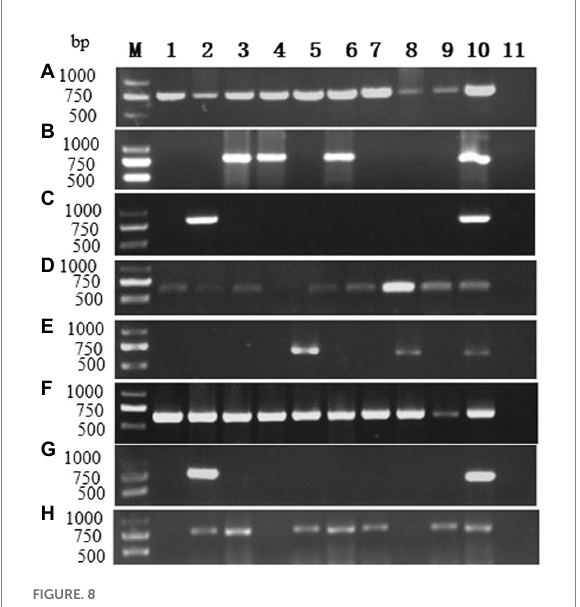
FIGURE. 8 RT-PCR detection for viruses in diseased plants of P. yunnanensis : (A) ParPV-3, (B) ParPV-4, (C) ParNV-1, (D) HCRV, (E) LycMoV, (F) PMNV, (G) ParV1, (H) PMMoV. Lanes (M) DNA marker, (1–9) diseased samples, (10) positive control and (11) is negative